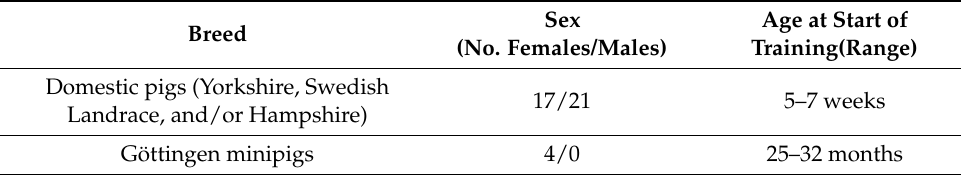
Sex Age at Start of (No. Females/Males) Training(Range)